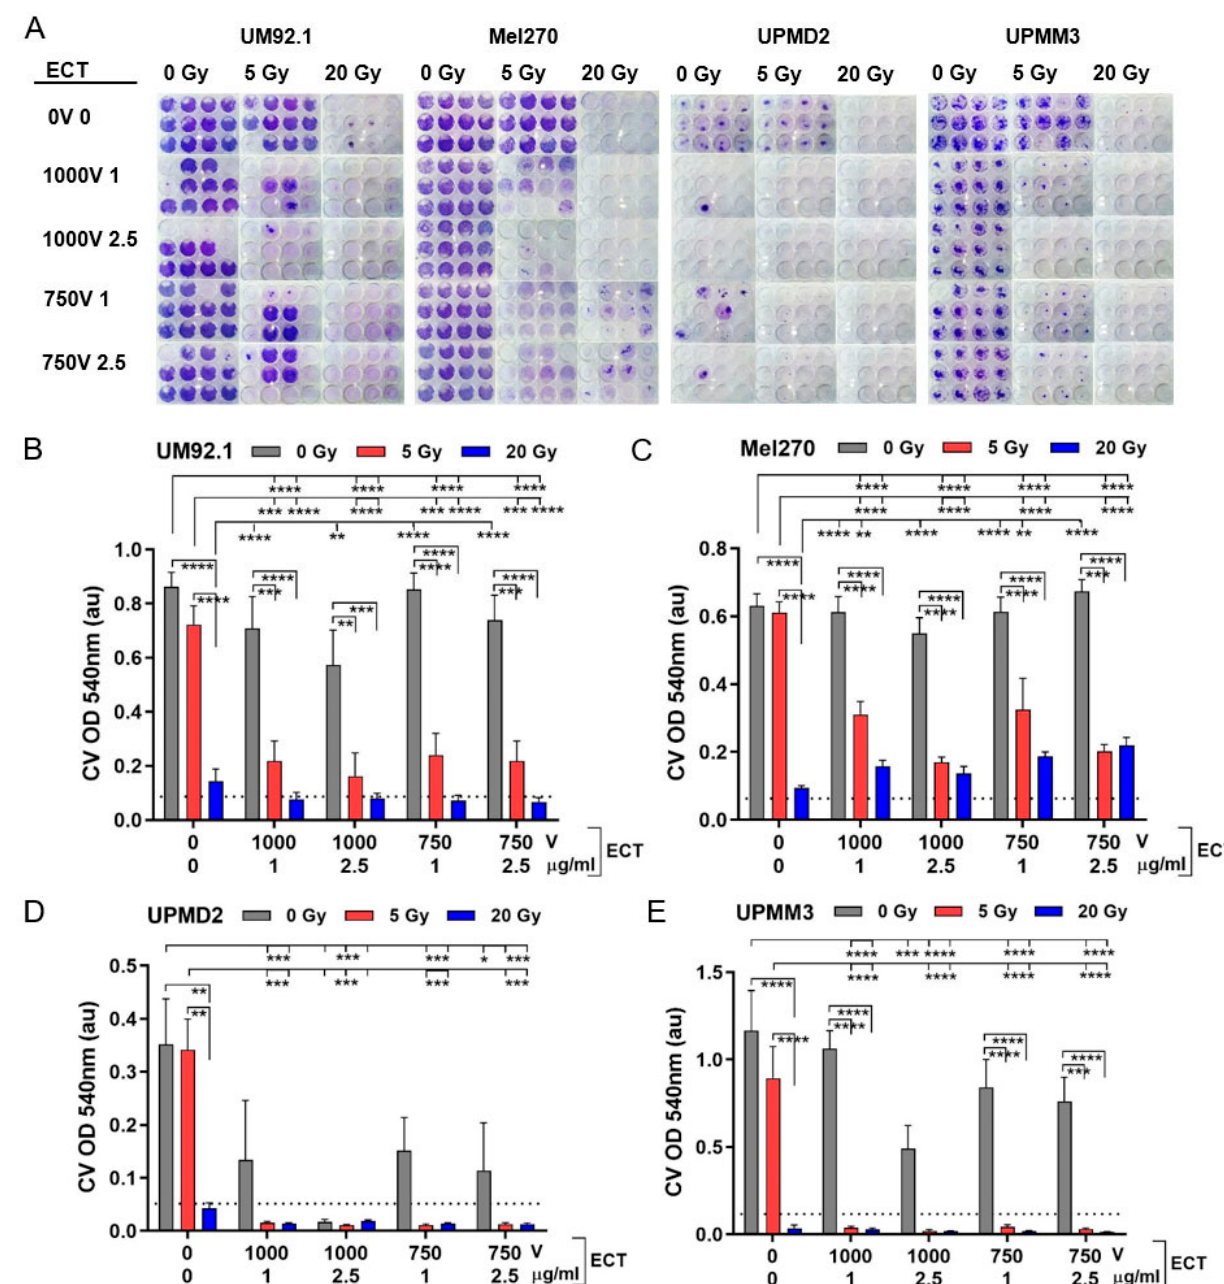
Figure 5. Long-term cytotoxicity of the treatments on tumor spheroid cells. At day 7, tumor spheroids were either irradiated (single dose 5 or 20 Gy) or treated with ECT (electroporation at 1000 V or 750 V in the presence of 1 µg/mL or 2.5 µg/mL bleomycin) or spheroids were first irradiated followed by ECT. The long-term cytotoxic effects on spheroids were determined in a spheroid cell survival assay. Each individual treated spheroid was allowed to attach to a flat bottom well at day 12. Spheroids were maintained in a culture to enable the out-growth of living cells. After eight weeks in the culture, the surviving cells were stained with Crystal Violet (CV). ( A ) Representative images of CV staining each condition are shown. ( B – E ) Measurements of CV staining (OD 540 nm, au: absorbance units, n = 12 each condition). Additionally, the 10% level of the mean value of untreated spheroids (0 Gy 0 V 0 µg/mL bleomycin) is shown in order to indicate the maximal tumor control potential (dotted line). Data are means ± SD. A statistical analysis was performed using a two-way ANOVA and Tukey’s multiple comparisons test; * p < 0.05, ** p < 0.01, *** p < 0.005, **** p < 0.001.